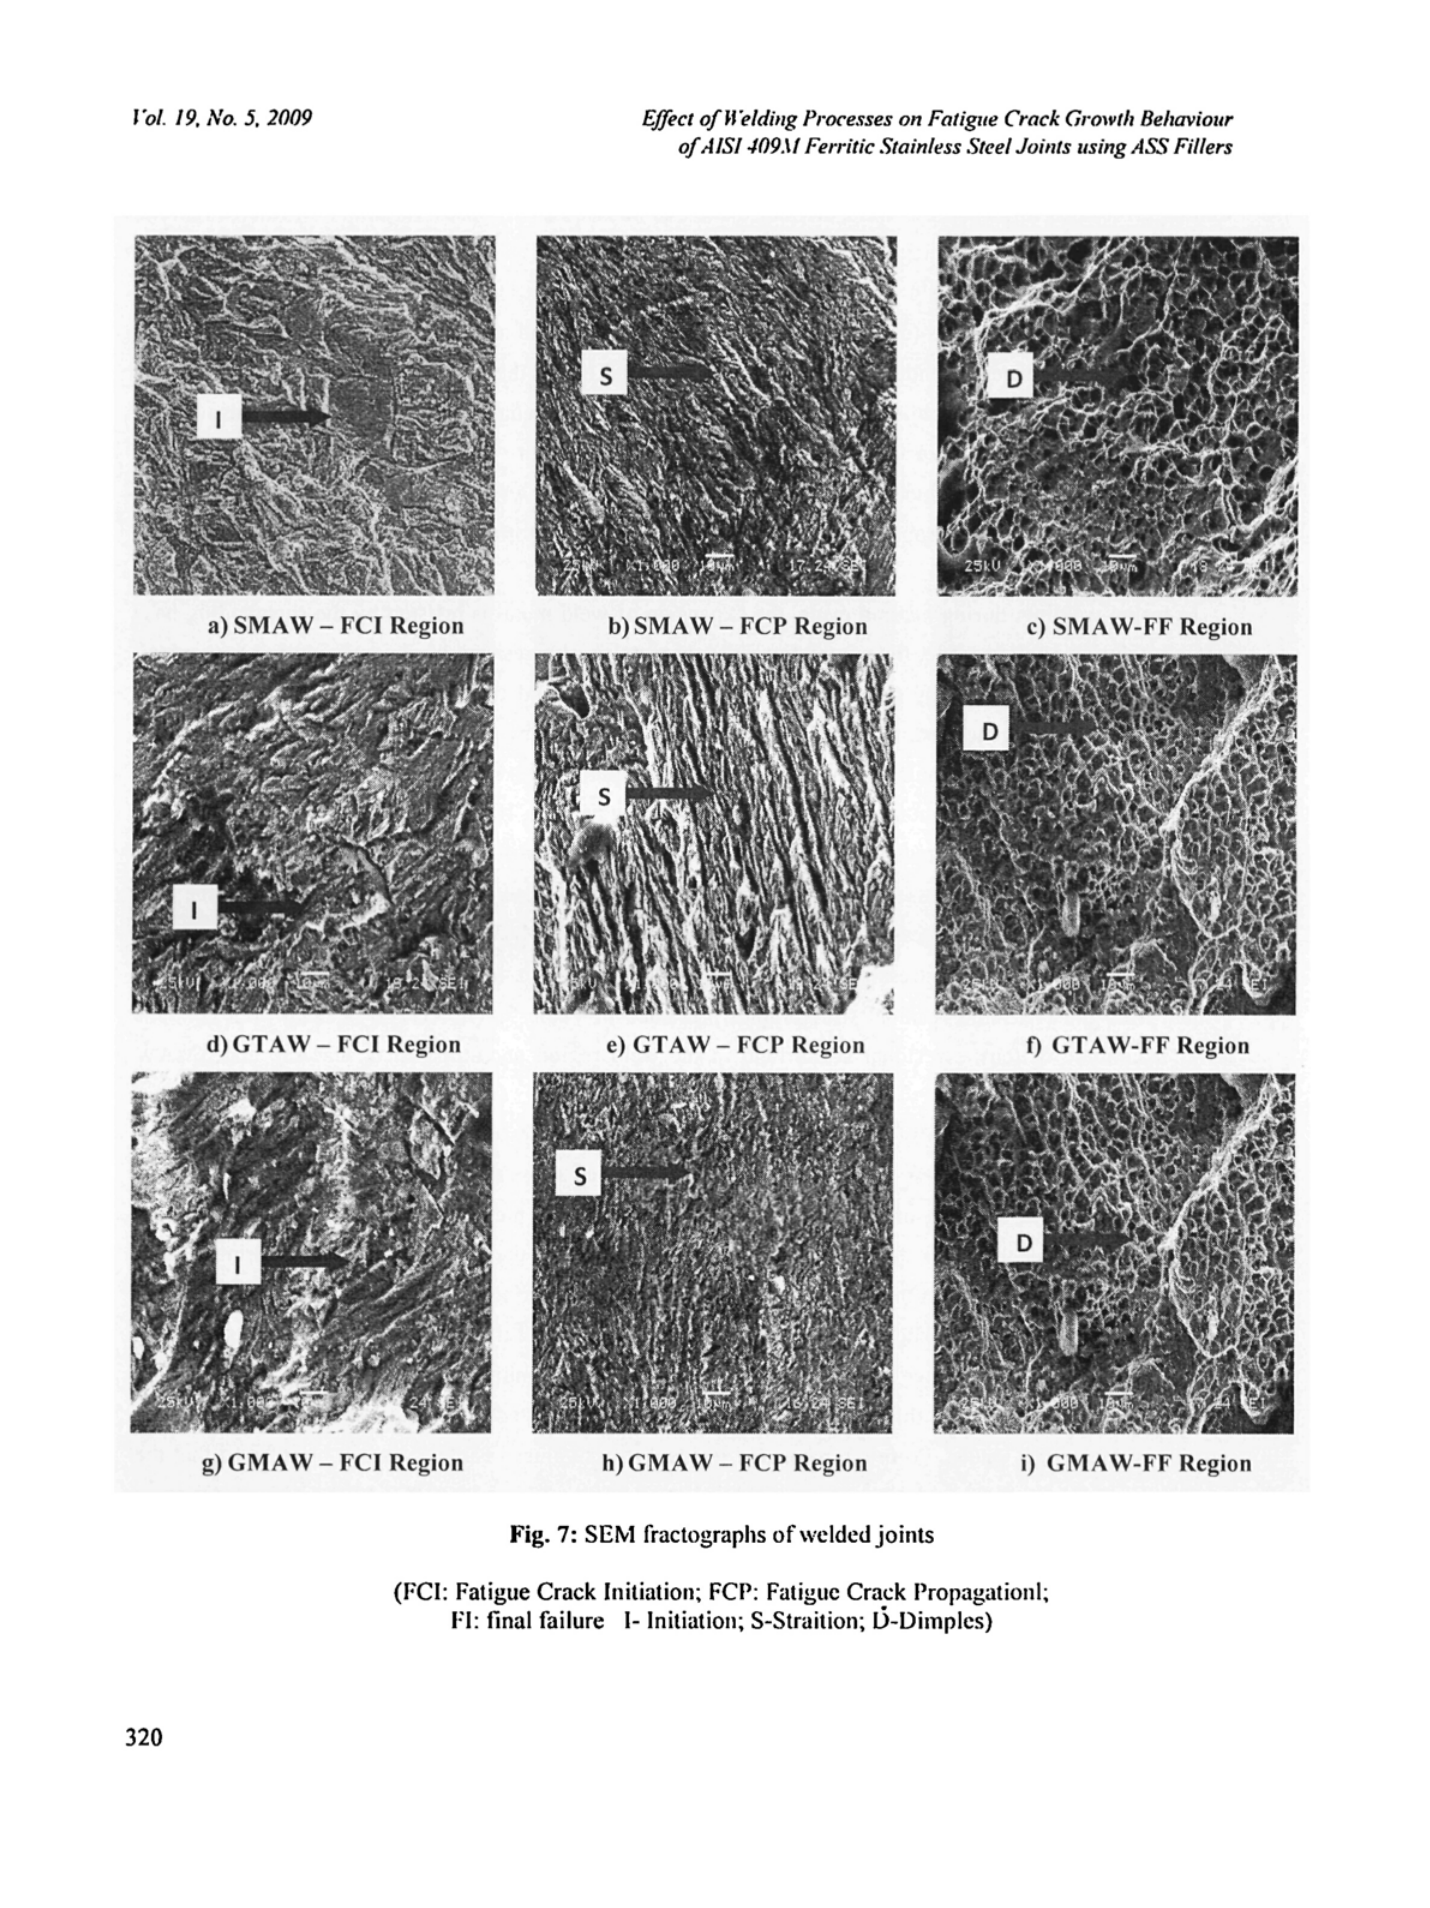
Fig. 7: SEM fractographs of welded joints (FCI: Fatigue Crack Initiation; FCP: Fatigue Crack Propagation!; FI: final failure I- Initiation; S-Straition;